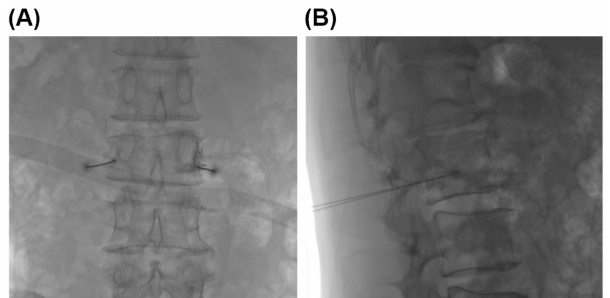
Figure 2. Gray ramus communicans nerve block procedures under the fluoroscopy. Anteroposterior ( A ) and lateral ( B ) fluoroscopic pictures show that it was confirmed through contrast media and images that the tip of the spinal needle is at the position of the gray ramus